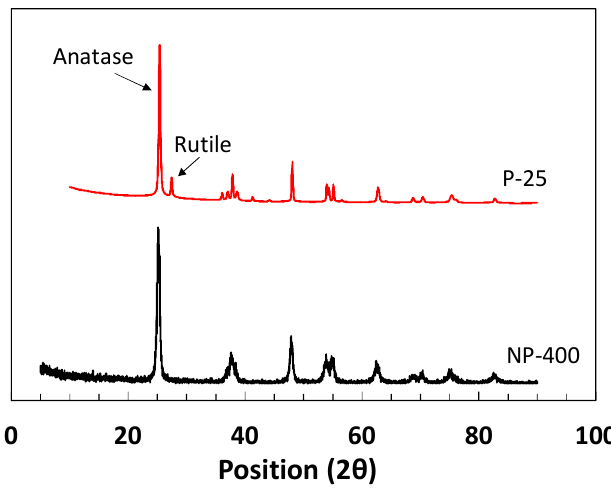
Figure 3. X-ray diffraction data for NP-400 and P-25 (Anatase: 2θ = 25.37°, Rutile: 27.41°).